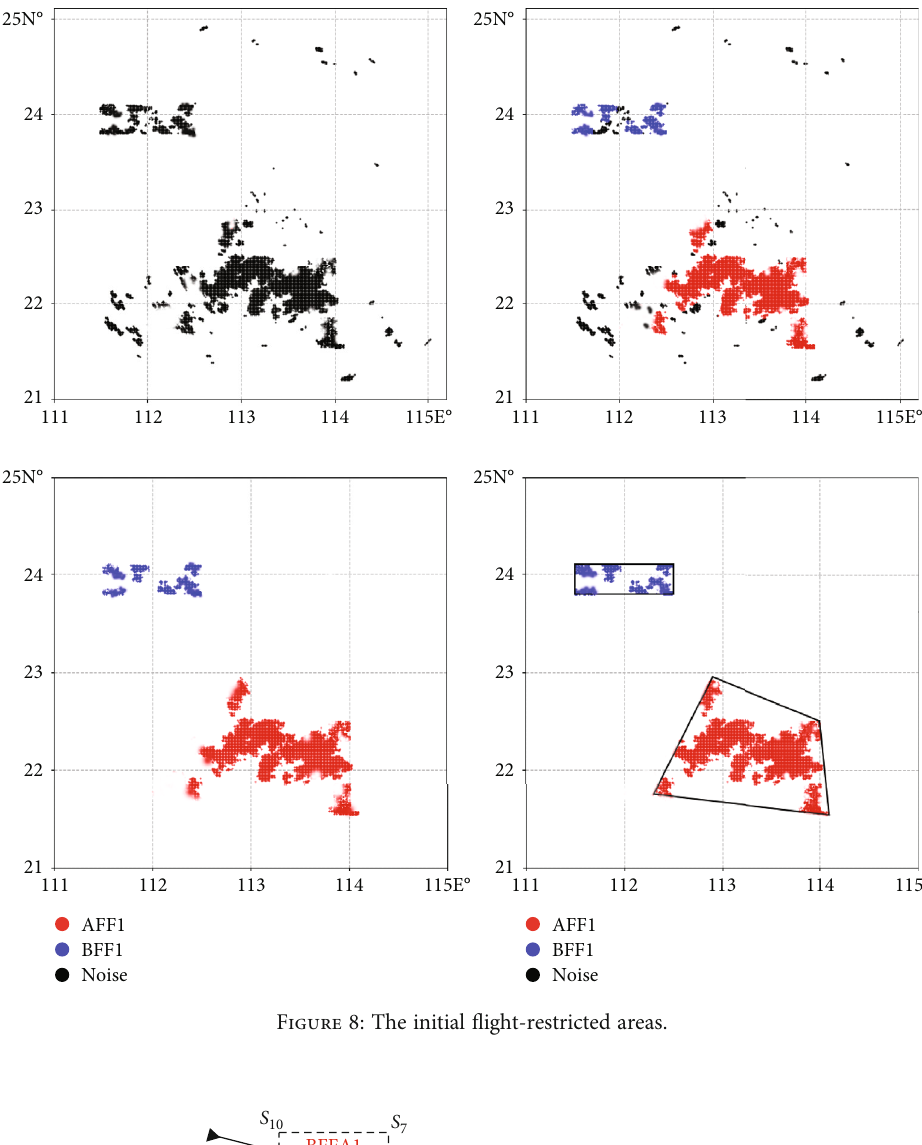
Figure 8: The initial fl ight-restricted areas.